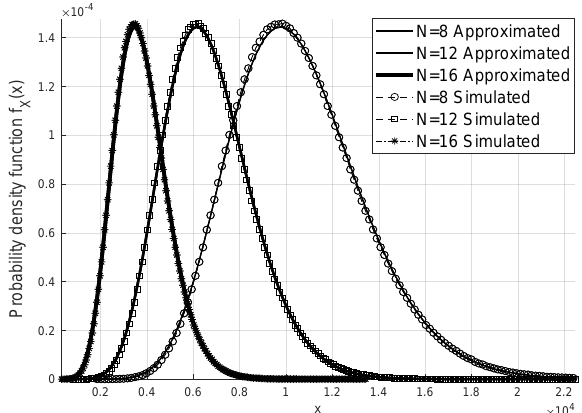
Figure 2. Approximated Gamma Distribution of (cid:107) w (cid:107) 2 without phase